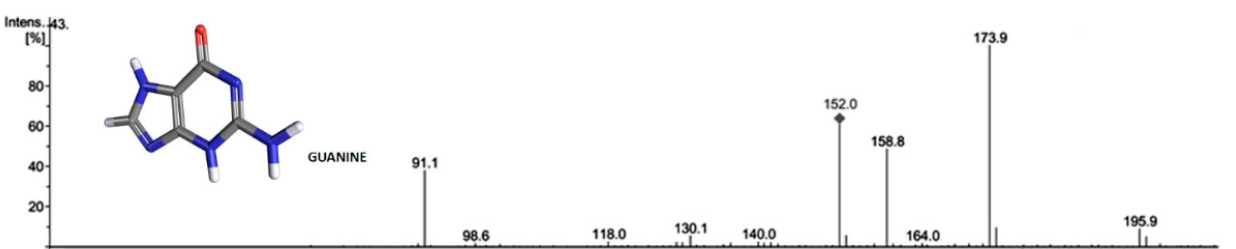
Figure 3. Mass spectrum of guanine identified in TSSMs and in their excreta.